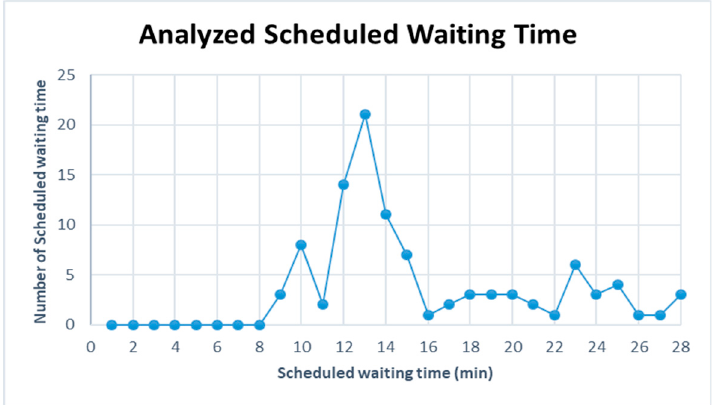
Figure 22. Analyzed Scheduled Waiting Time for Case 6.